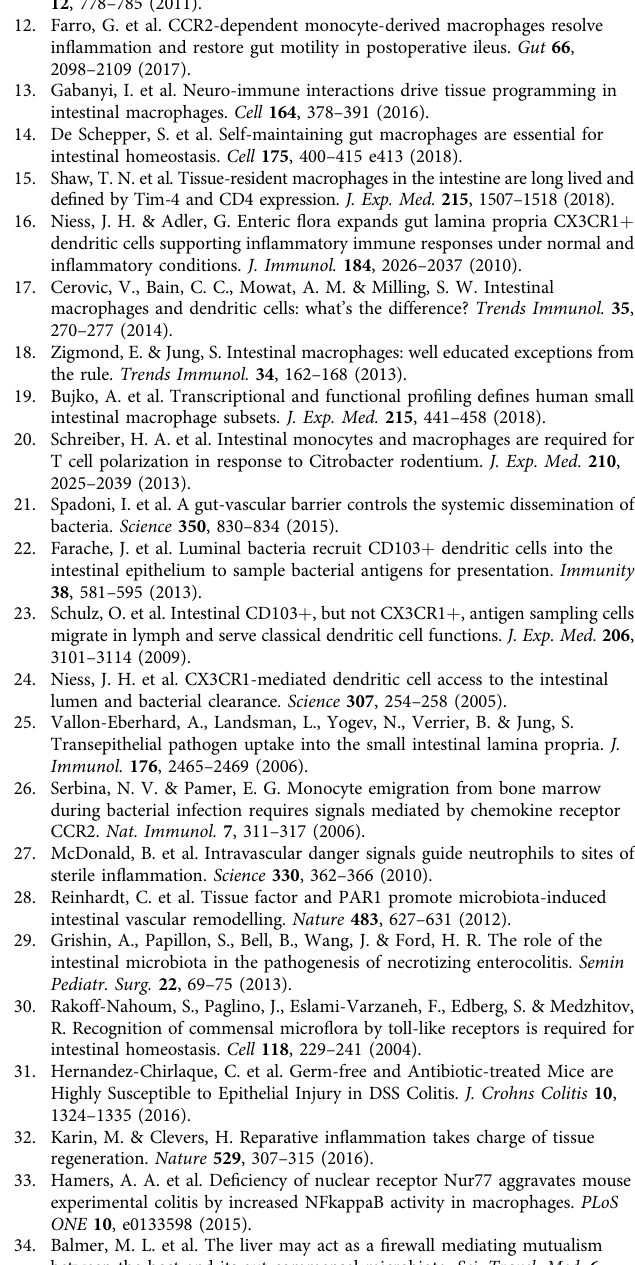
Fig. 8 Gut microbiota affects the tissue repair process in DSS colitis. a Macroscopic fi ndings of the colon 7 days after the start of DSS water in control and Abx-treated mice (left) and quanti fi cation of colon length (right; n = 8 – 14 per group). Luminex assays of b pro-in fl ammatory cytokines, c chemokines in colon tissue samples at steady state and at 7 days of DSS-treatment ( n = 5 – 7 per group). Quanti fi cation of d monocyte hues and e CD31 + area within injury site of lamina propria in control and Abx-treated Cx3cr1 GFP/ + Ccr2 RFP/ + mice at 7 days of DSS-treatment. n = 3 – 5 per group. f Quanti fi cation of the number of CX3CR1 + macrophages (total, CD80 + CD206 − , or CD80 - CD206 + ) in colon isolated from control and Abx-treated mice after 7 days of DSS treatment. Cells were pregated on size, viability, CD45 + , CD103 − , CD11b + , and F4/80 + . n = 4 – 5 per group. g Survival of control and Abx-treated mice in 2% DSS-treatment. n = 10 per group. Data were pooled from two independent experiments. h Colonic blood score 7 days after the start of DSS water ( n = 8 – 14 per group). i Body weight change of control and Nr4a1 − / − mice in 2% DSS colitis. n = 10 per group. j Quanti fi cation of colon length and colonic blood score ( n = 9 – 14 per group). k Representative stitch images of lamina propria and l quanti fi cation of monocyte hues and CD31 + area/injury area in Cx3cr1 GFP/ + Ccr2 RFP/ + and Nr4a1 − / − Cx3cr1 GFP/ + Ccr2 RFP/ + mice at 7 days of DSS-treatment. White dotted line indicates injury area. Scale bars, 100 μ m. n = 3 – 5 per group. Data represent mean±SEM. * p <0.05, ** p <0.01, *** p <0.001, **** p <0.0001, NS not signi fi cant. Source data are provided as a Source Data fi